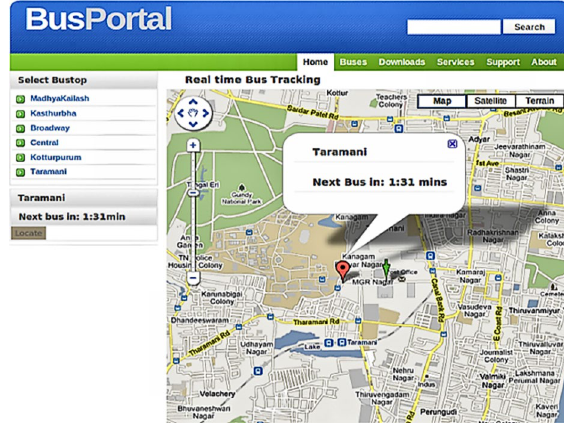
Fig. 10. Website showing the bus location and